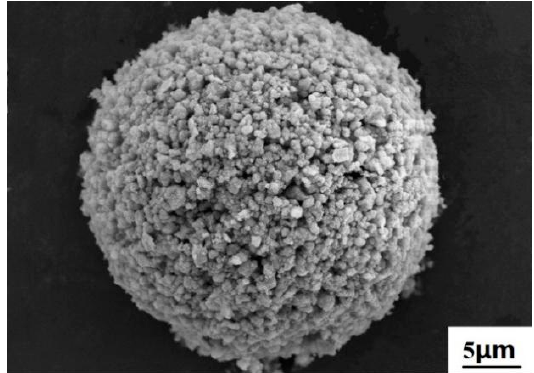
Figure 1. The morphology of agglomerated powder.